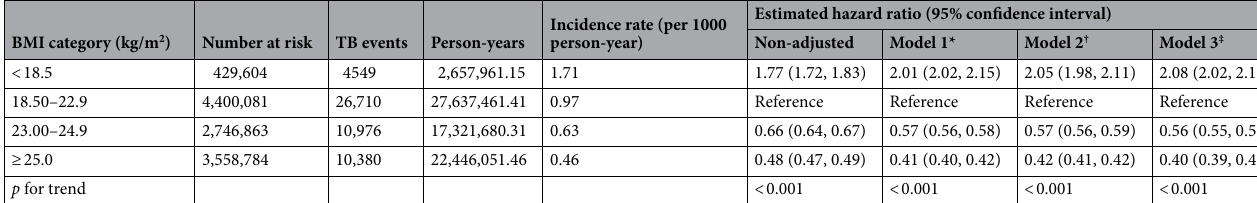
Table 2. The incidence and risk of tuberculosis by BMI category. BMI body mass index. *Adjusted for age and sex. † Adjusted for variables in model 1, smoking, alcohol consumption, regular exercise and low-income status. ‡ Adjusted for variables in model 2, hypertension, diabetes mellitus and dyslipidemia.